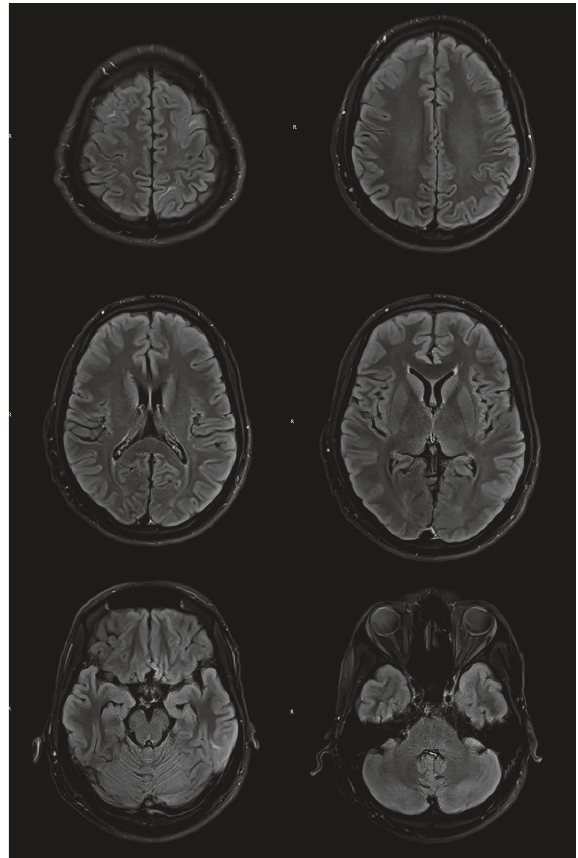
Figure 1: T2 FLAIR sequence. MRI brain (done on Day 4 of heat stroke) showed widespread T2 FLAIR hyperintensities over both cerebral and cerebellar hemispheres, predominantly the cortex and the subcortical white matter.